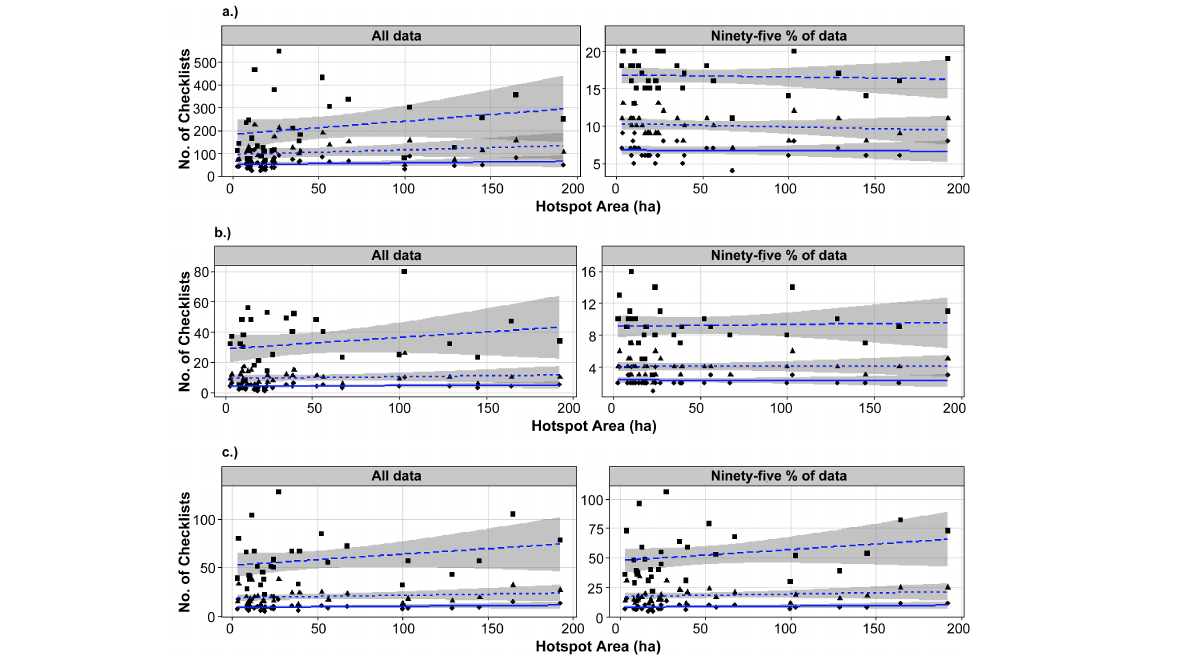
Fig. 2 . Relationships between hotspot area and the number of checklists to meet the necessary thresholds included in the analysis for (a) species richness, (b) Shannon diversity, and (c) community composition (Bray-Curtis similarity) for 70% (circles), 80% (triangles), and 90% (squares) threshold levels. Separate analyses are provided for the full dataset, and for those species recorded on > 5% of all checklists at the site.